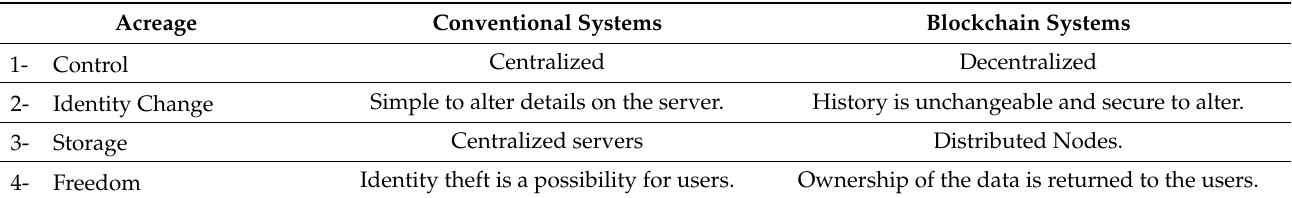
Table 1. Comparison between centralized and decentralized.